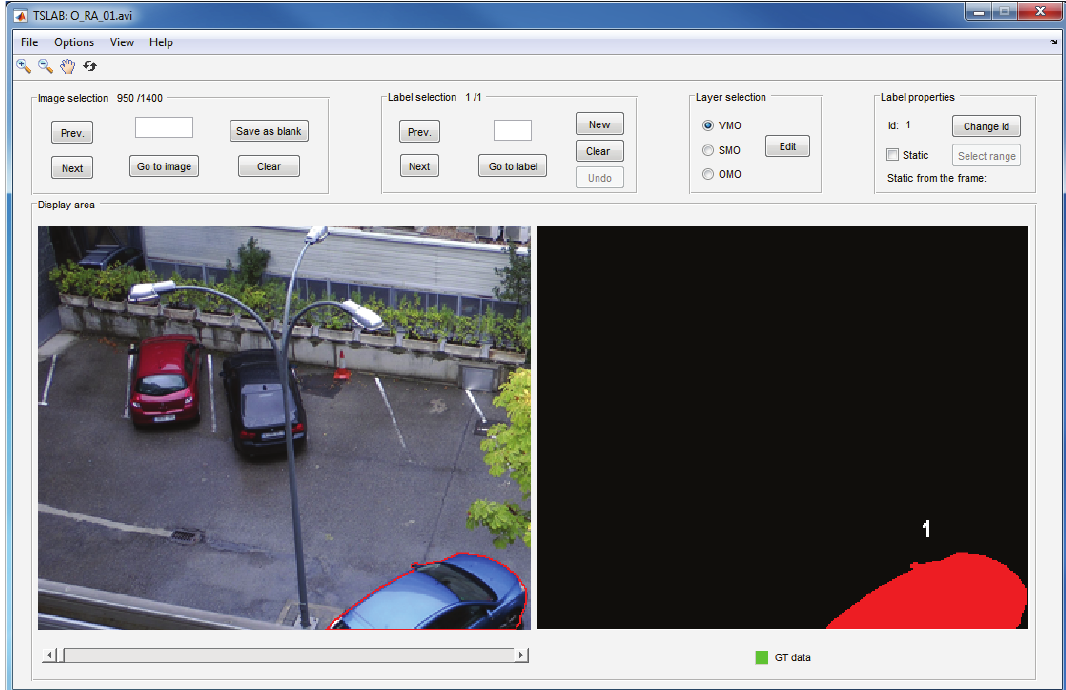
Figure 4. Navigation